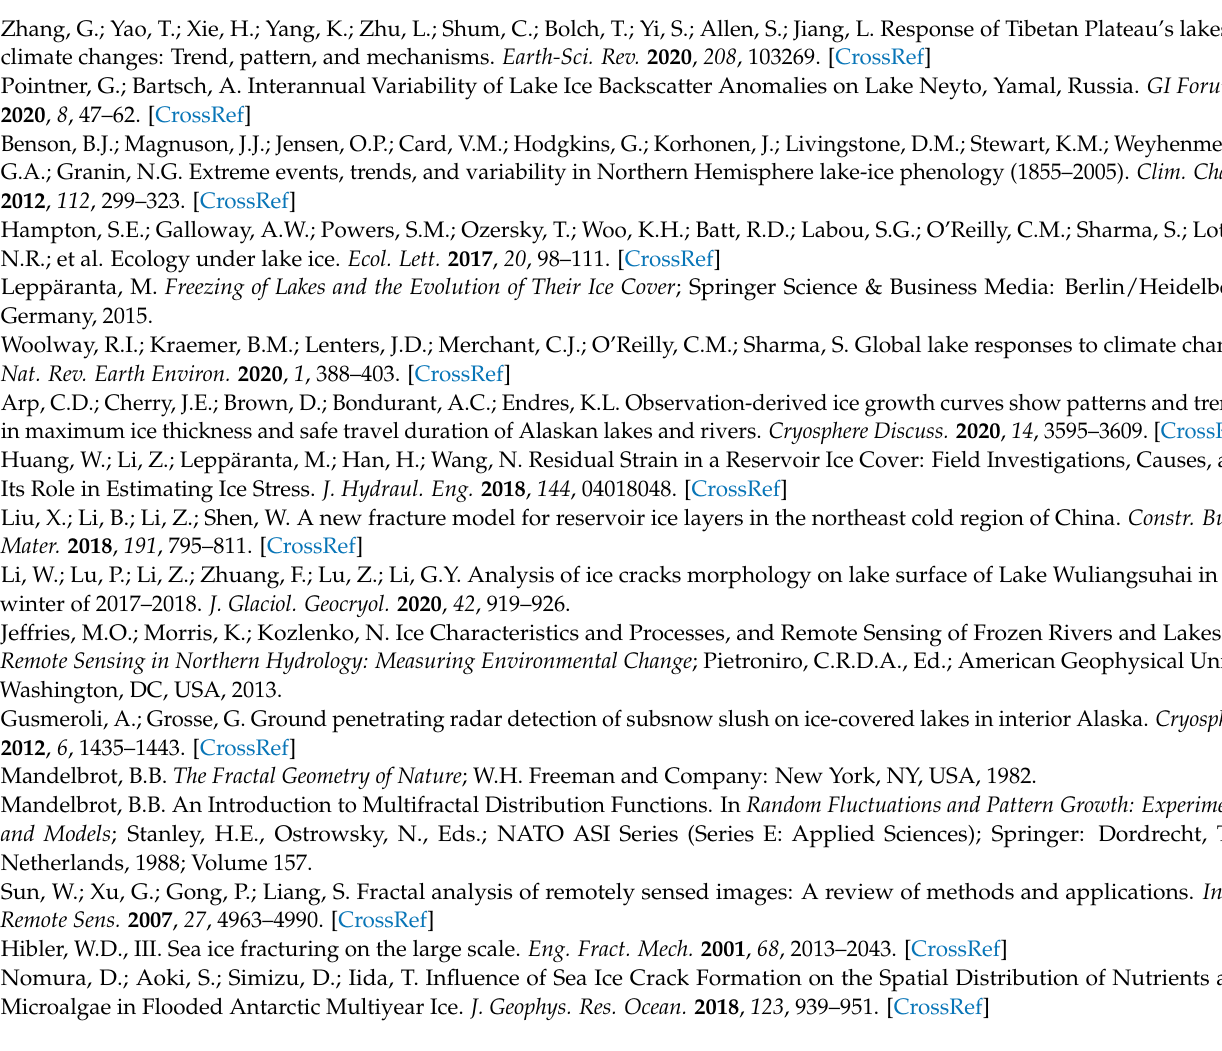
Figure A2. The planar distribution map of flow velocity of Chagan Lak in October simulated by Delft3D platform (Liu et al., 2020).